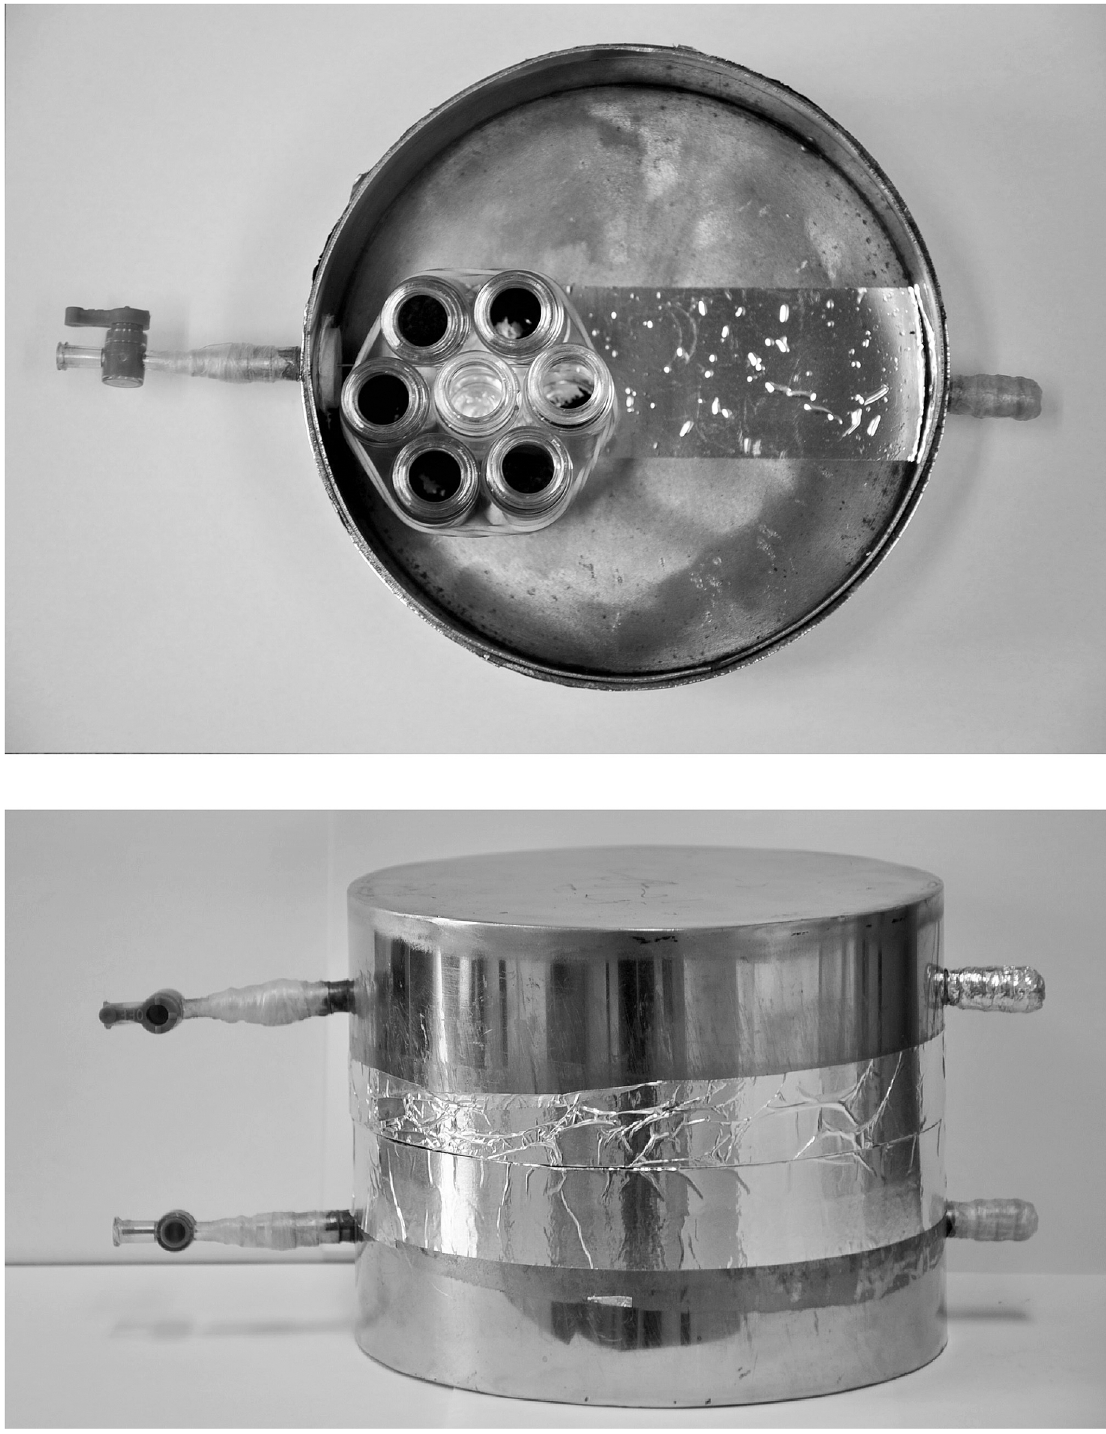
Fig 2. Adsorption